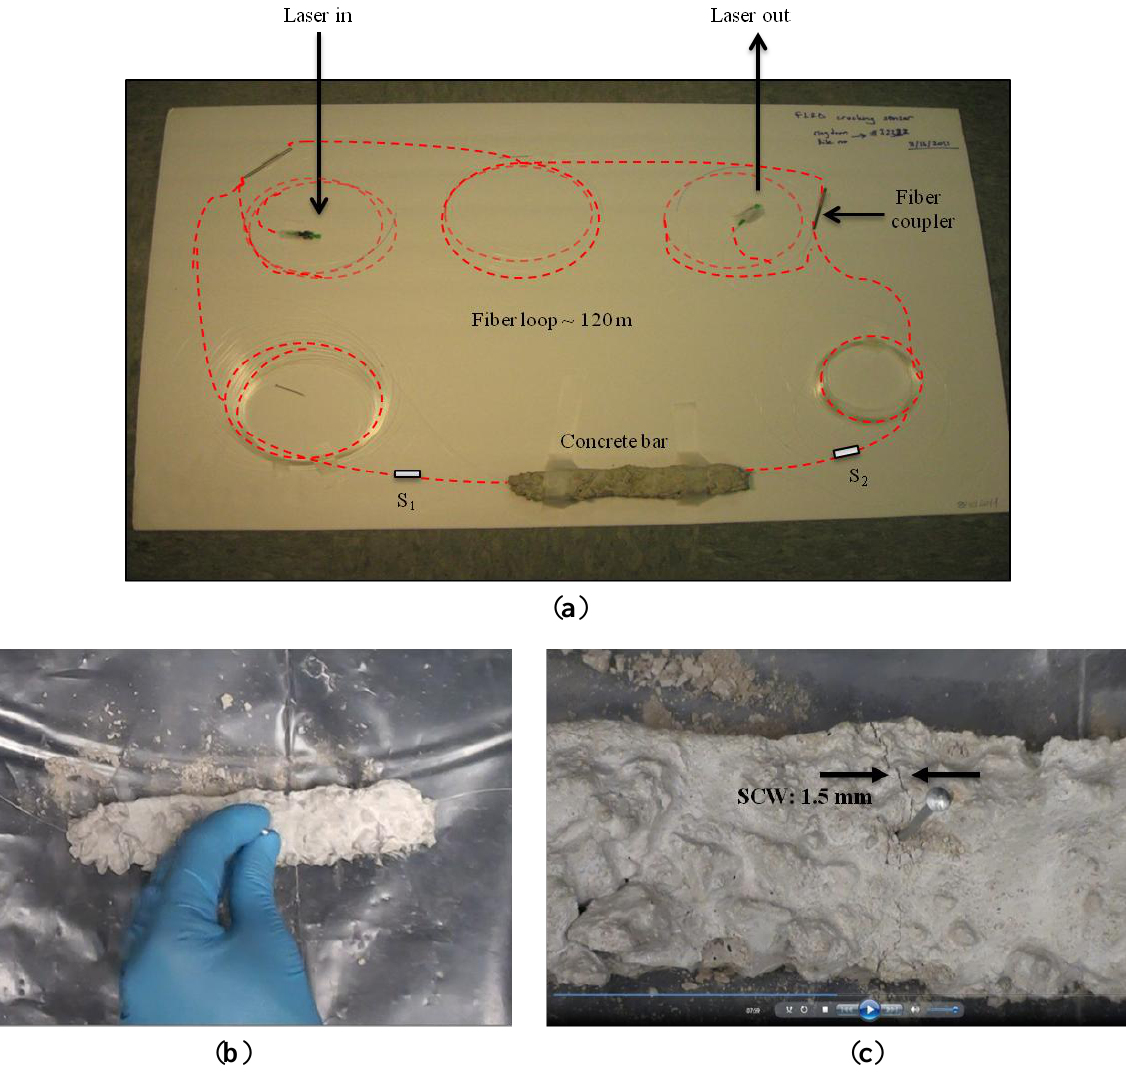
Figure 3. ( a ) An image of a FLRD crack sensing unit: showing the fiber loop connected to the sensor head (concrete bar). ( b ) An image showing the manual procedures to produce cracks in the concrete bar. ( c ) A typical surface crack as it appears on the top surface of the